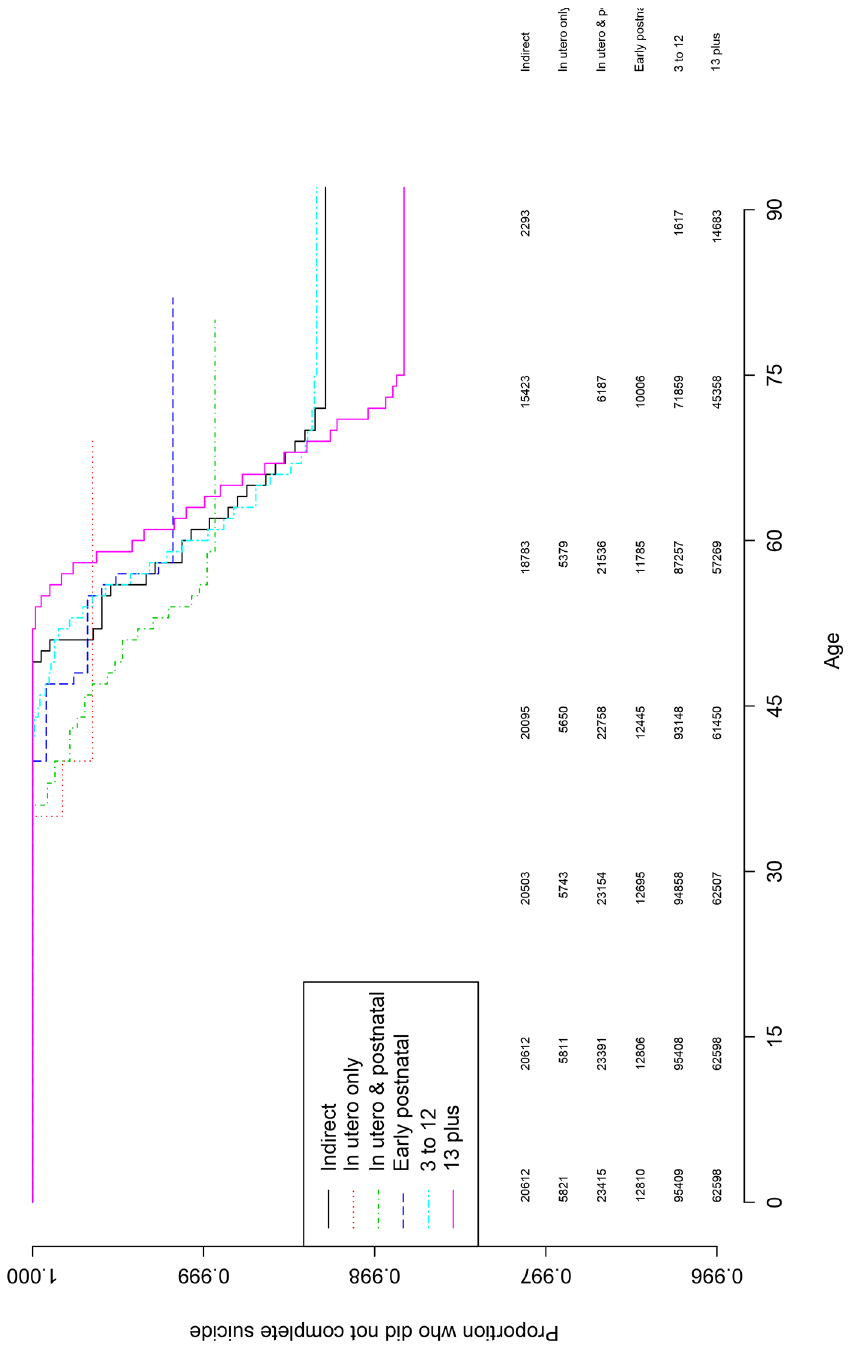
Fig 3. Kaplan-Meier survival curve for the cumulative probability of suicide risk for the indirect, in utero only, in utero and postnatal exposure, ages 3 to 12 and 13 plus exposure subgroups. Note. The curves depict average age of suicide for the exposure groups based on Kaplan-Meier modeling estimates. The vertical axis is the proportion that did not complete suicide. The numbers under the horizontal axis are age, and the numbers above the x-axis are the numbers at risk every 15